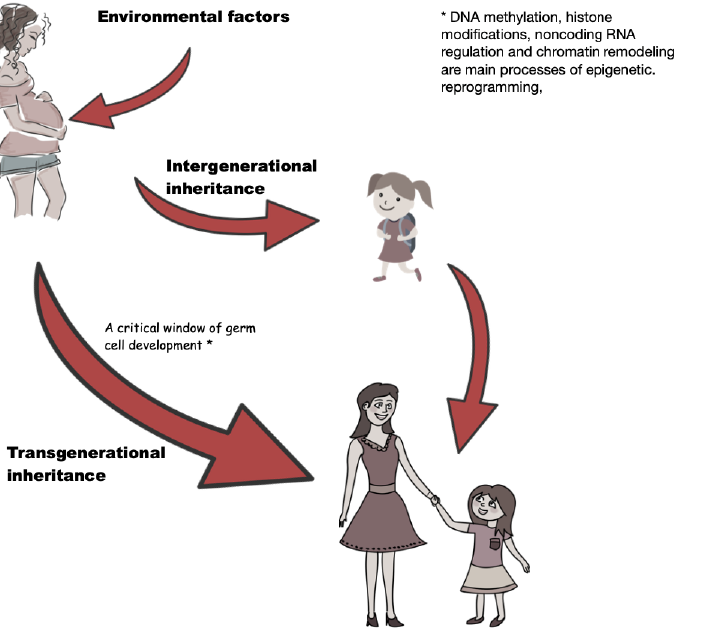
Figure 1. Exposure during pregnancy means direct influence on mother and fetus (intergenerational) and developing primordial germ cells of growing fetus (transgenerational